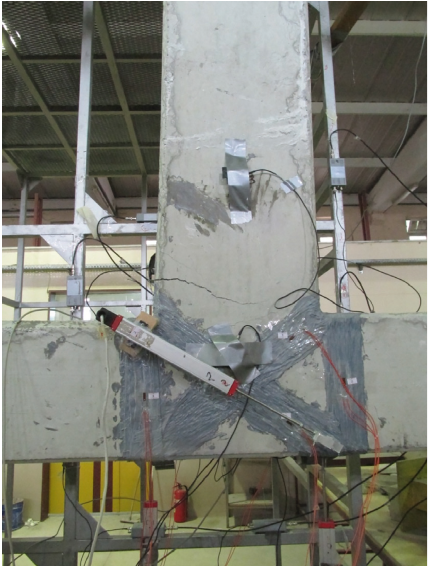
Figure 11: Failure of Sample 1.